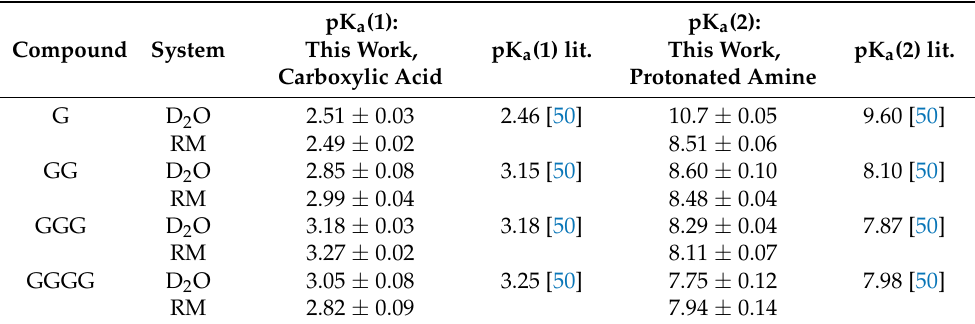
Table 2. Comparison of experimental pK a values obtained for G compounds in aqueous (D 2 O) and w 0 10 RM systems, shown with 95% confidence intervals, with literature aqueous pK a values. pK a (1): pK a (2): Compound System This Work, pK a (1) lit. This Work, pK a (2) Carboxylic Acid Protonated Amine